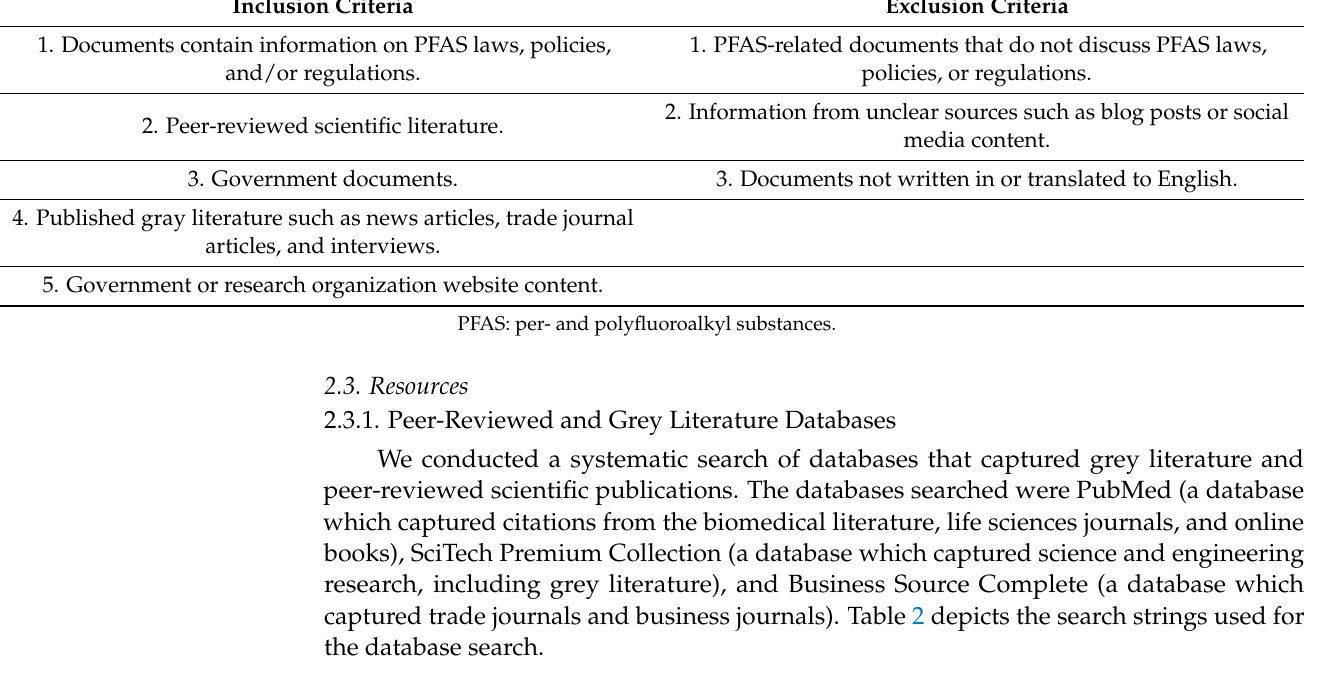
Table 1. Inclusion and exclusion criteria. Documents were considered relevant if they met inclusion criteria 1 and were from a source described in inclusion criteria 2–5. Documents were considered not relevant if they met any of the exclusion criteria. Inclusion Criteria Exclusion